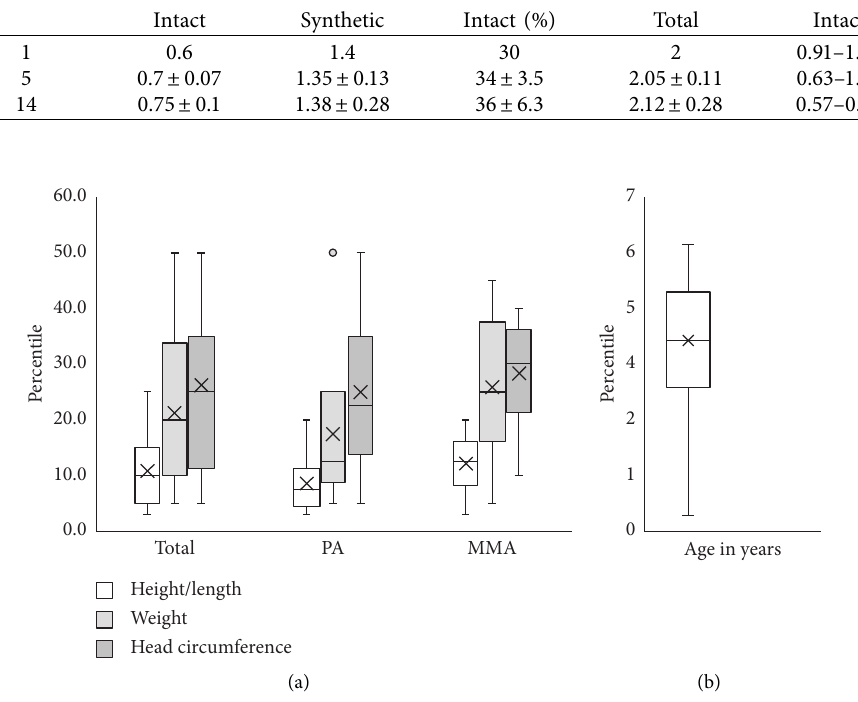
Figure 2: (a) The different growth parameters of the study group, and (b) the age of the study